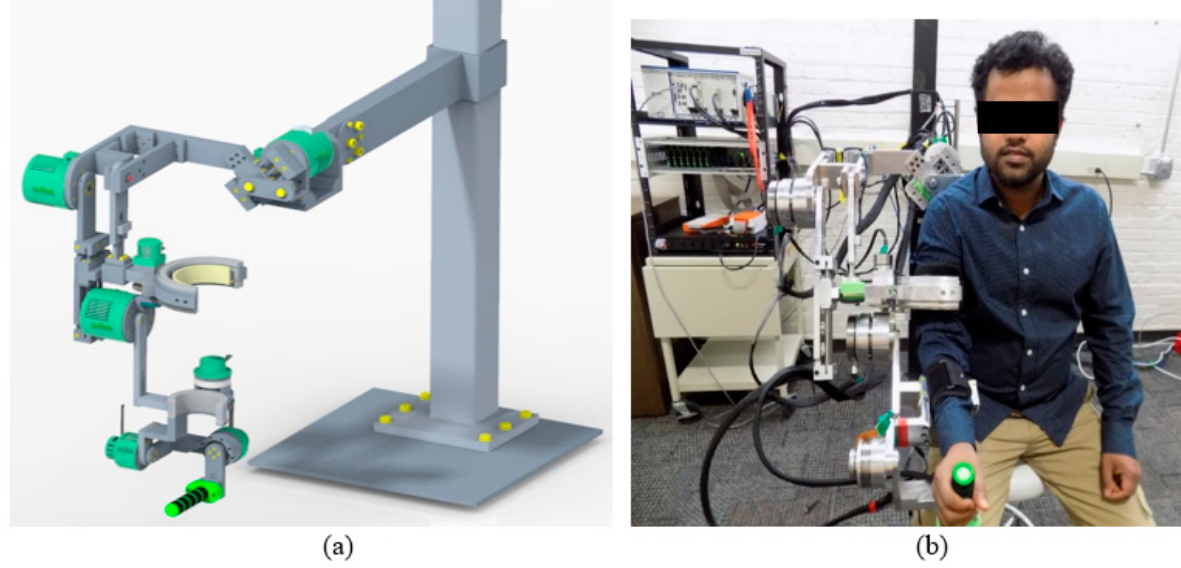
Figure 1. ( a ) Rendered CAD model of the u-Rob exoskeleton robot and ( b ) a subject wearing the u-Rob exoskeleton robot.